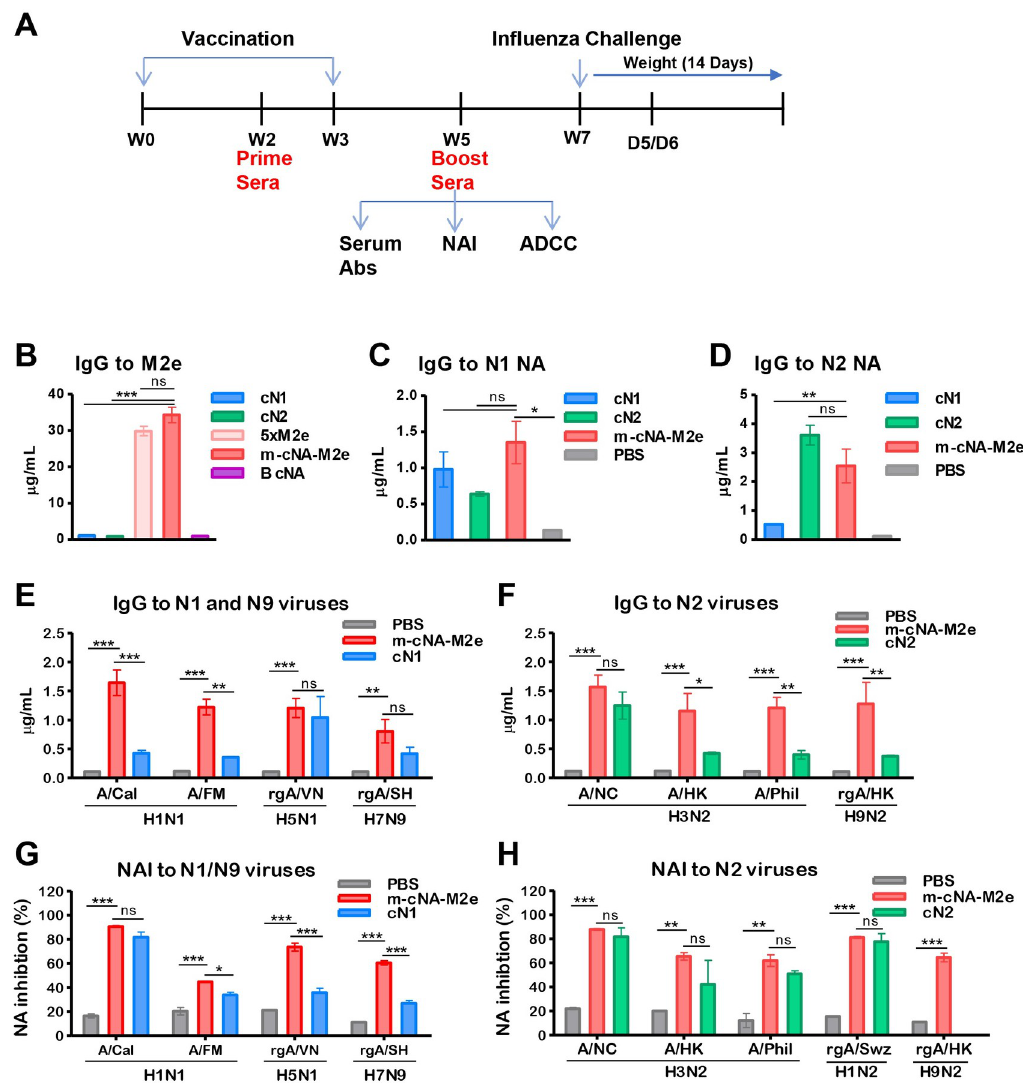
Fig 2. Vaccination with m-cNA-M2e VLP induces IgG antibodies specific for M2e, NA, multi subtype viruses, and broad NA inhibition activity. (A) Schematic overview of vaccination of mice, prior to influenza virus challenge. BALB/c mice (n = 10 per group) were intramuscularly immunized twice with each VLP vaccine as indicated. Boost sera (W5) were used for measuring IgG, NAI, and ADCC assay, followed by intranasal (IN) influenza virus challenge at W7 and tissue samples were collected at day 5 or 6 post infection for lung viral titers. cN1: monomeric consensus cN1 NA VLP (3 μ g), cN2: monomeric cN2 NA VLP (3 μ g), 5xM2e: monomeric 5xM2e VLP (3 μ g), m-cNA-M2e VLP: multi-subtype consensus NA (cN1-cN2-B cNA) plus 5xM2e VLP (10 μ g). B cNA: monomeric consensus B NA VLP (3 μ g). Na ï ve mice (PBS) were used as a mock control. ( B-F ) IgG antibodies in concentrations as determined by ELISA. IgG antibodies specific for M2e (B) , N1 NA (A/Cal/2009 H1N1) (C) , N2 NA (A/Brisbane/2007 H3N2) (D) , inactivated influenza viruses ( E and F ) in boost immune sera. (G and H) Neuraminidase (NA) inhibition activities in 40-fold diluted boost immune sera by ELLA. rgA/PR8-Swz (rgAH1N2): reassortant containing N2 of A/Switzerland/2013 (H3N2) and A/PR8 (H1N1) backbone. All viruses and vaccine groups are as described in Materials and Methods. Data represented as mean ± SEM; statistical significances were performed by (B-D) one-way ANOVA and (E-H) Turkey’s comparison and two-way ANOVA with Bonferroni posttest and indicated as �� , P < 0.01; ��� , P < 0.001. Next, we compared the efficacy of m-cNA-M2e VLP, cN1 VLP, cN2 VLP, and 5 × M2e VLP after challenge with rgA/VN H5N1 virus (Fig 3G). The m-cNA-M2e VLP and cN1 VLP groups showed a similar pattern of weight loss (~9%) at days 4 to 6 post challenge whereas 5 × M2e